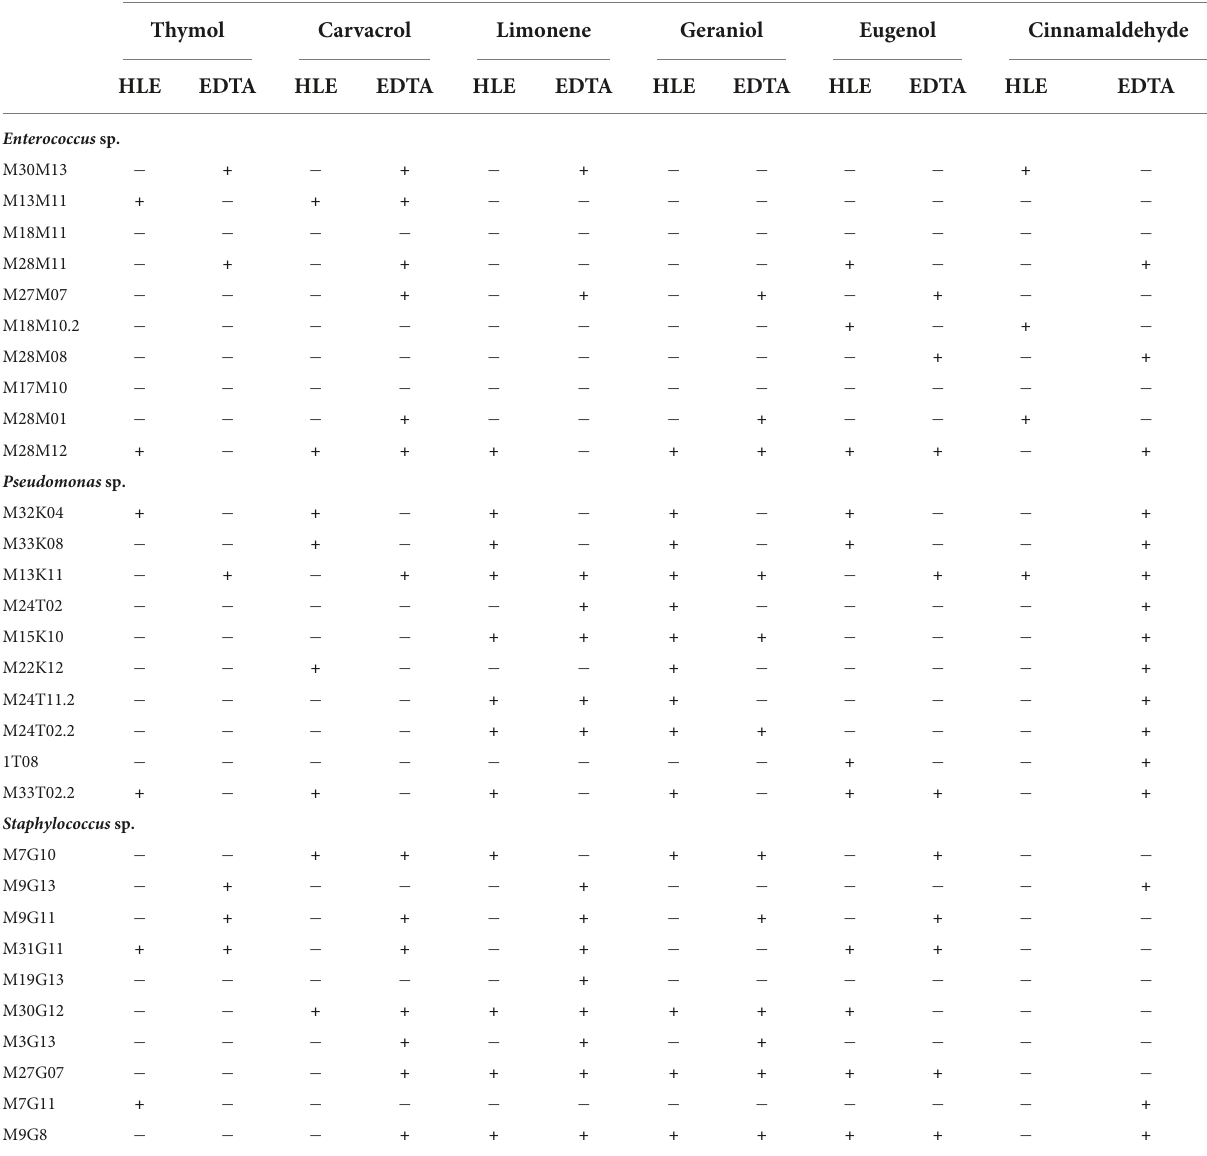
TABLE 5 Synergies detected between EOCs and HLE or EDTA against Enterococcus sp., Staphylococcus sp. and Pseudomonas sp. strains isolated throughout meat chain production in a lamb and goat slaughterhouse of Jaén. Bacteria Thymol HLE